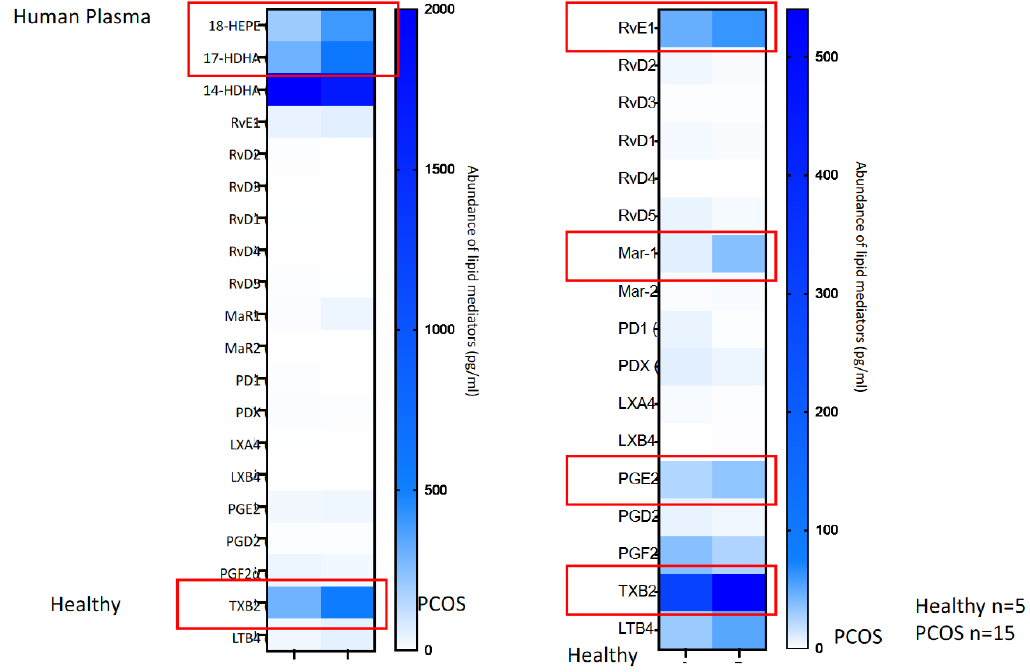
Figure 4. Heat map results in pg/mL of the human plasma analyses of the healthy and PCOs patients.